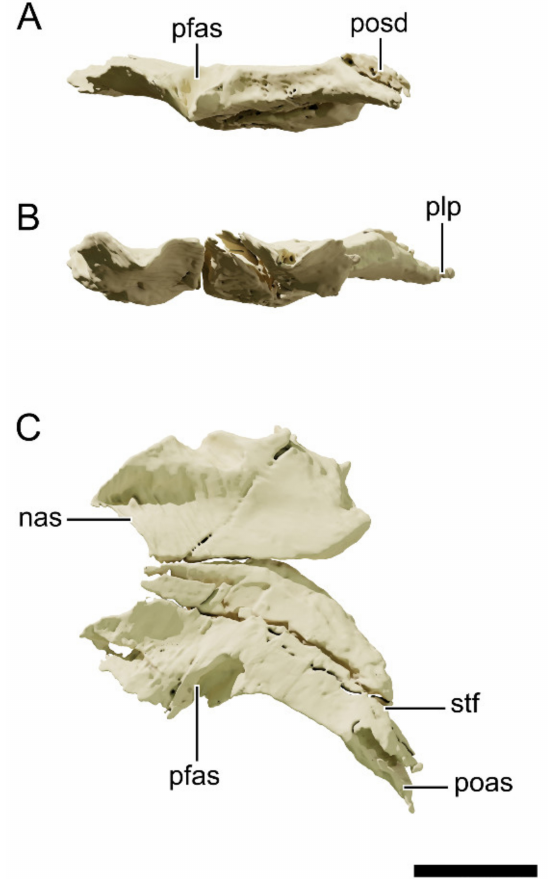
Figure 20. Digital reconstruction of the frontals of NHMD 164741. ( A ) Lateral view. ( B ) Anterior view. ( C ) Dorsal view. The left and right frontals were digitally articulated. Abbreviations: nas, articular surface for the nasal; pfas, articular surface for the prefrontal; poas, articular surface for the postorbital; plp, posterolateral process; stf, supratemporal fossa. Scale bar = 20